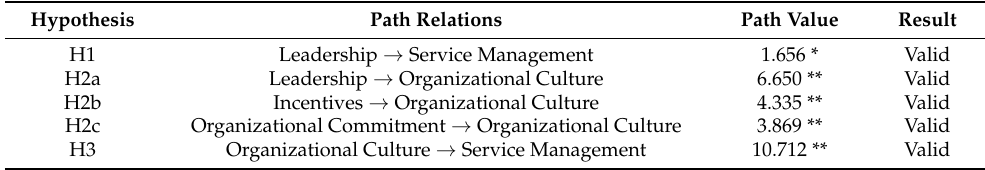
Table 5. Results of hypotheses validation.